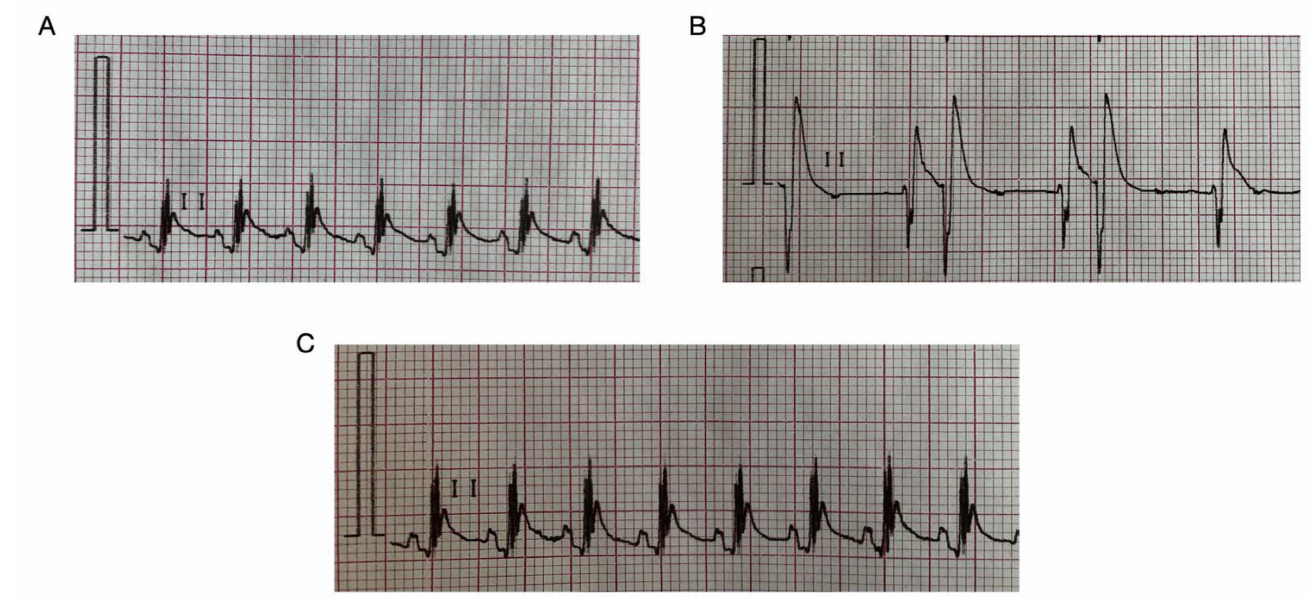
Figure 1. Representative ECG traces after treatment with adrenaline and/or HBK-10. ( A ) Normal reading (Control). ( B ) Arrhythmia control—adrenaline (20 µ g/kg, iv ). ( C ) Adrenaline-induced arrhythmia (20 µ g/kg, iv ) + HBK-10 (0.25 mg/kg, ip injection 45 min prior to